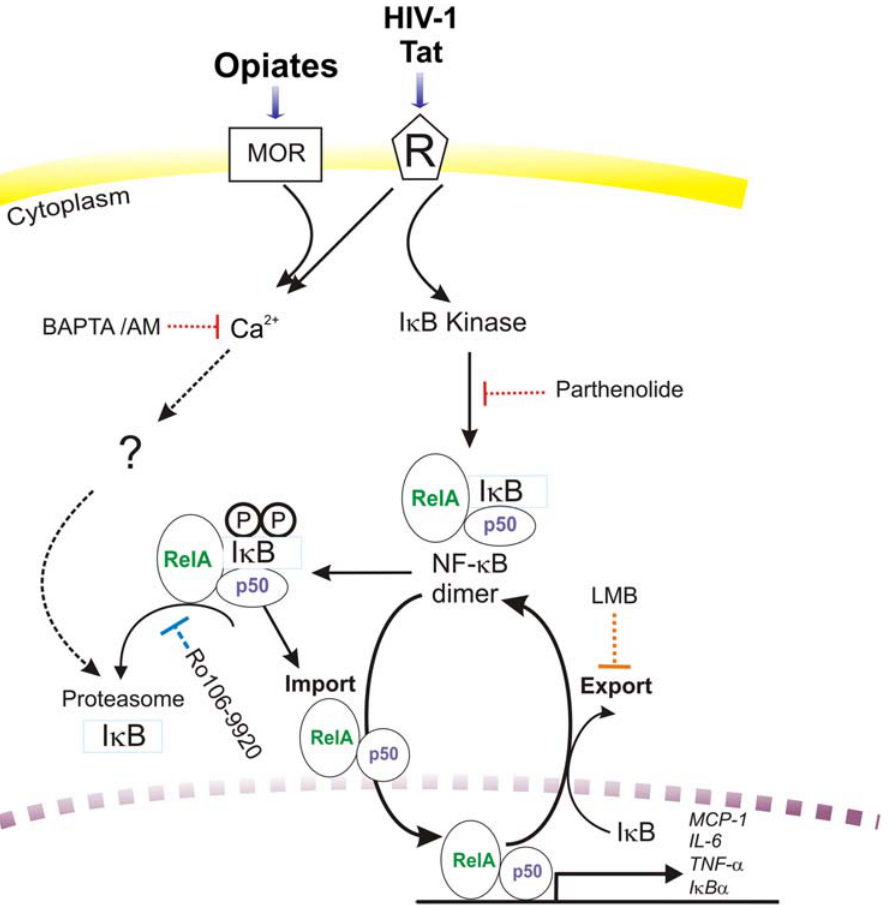
Figure 7. Proposed model for the involvement of NF- k B signaling in the regulation of cytokine and chemokine in Tat 6 morphine treated astrocytes. Arrows indicate activation of the signaling pathway; the ‘‘ I ’’ signs indicate pathway inhibition. Exposure to Tat alone increases I k B phosphorylation/degradation and NF- k B transcriptional activity, and additionally increases [Ca 2 + ] i in astrocytes [48]. Although morphine treatment alone fails to significantly activate NF- k B in astrocytes, in combination with Tat it can potentiate Tat-induced increases in [Ca 2 + ] i at sites upstream of NF- k B [37]. How [Ca 2 + ] i affects I k B degradation in the present study is uncertain (?), but may involve increased oxidative stress [55], and decreased proteasome